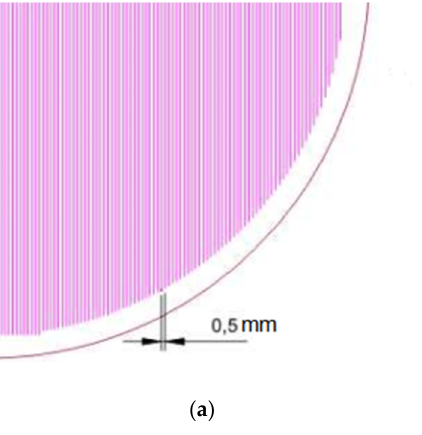
Figure 3. ( a ) geometrised aluminium foil design ( b ) real geometrised aluminium mould used for vulcanisation.